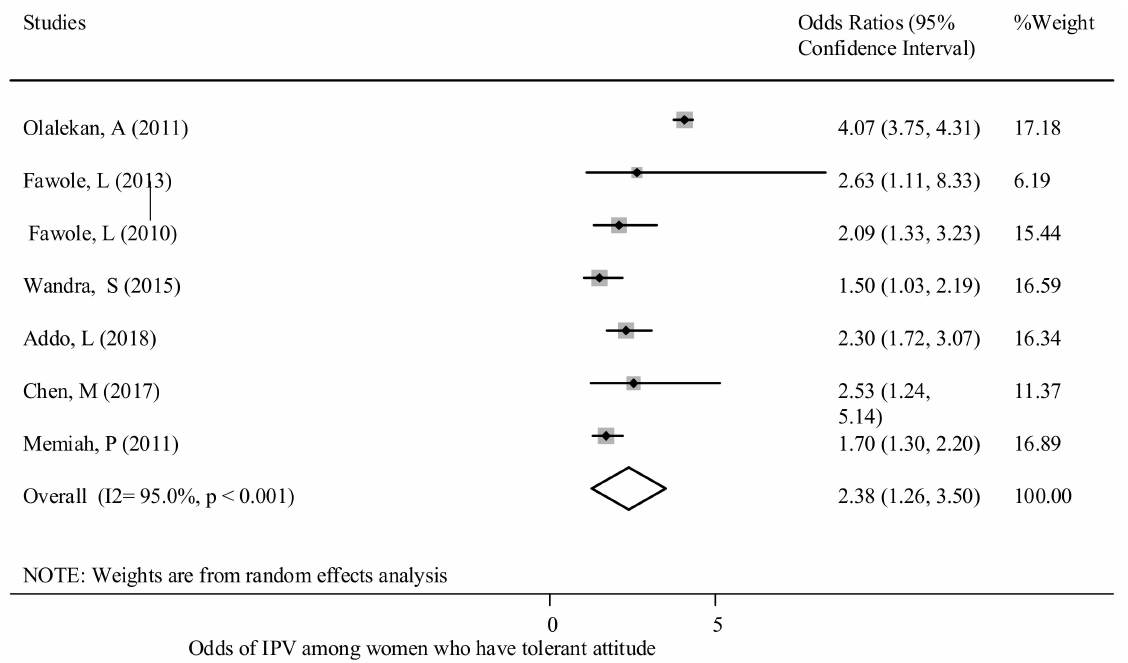
Figure 6. The association between tolerant attitude and experience of reporting GBV in SSA.